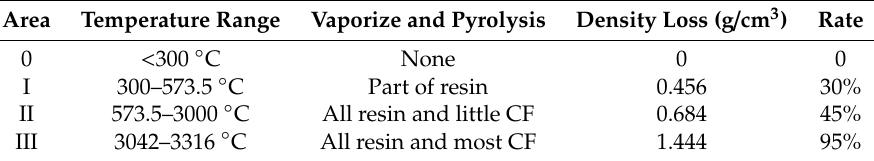
Table 4. Properties of di ff erent temperature areas in CFRP.